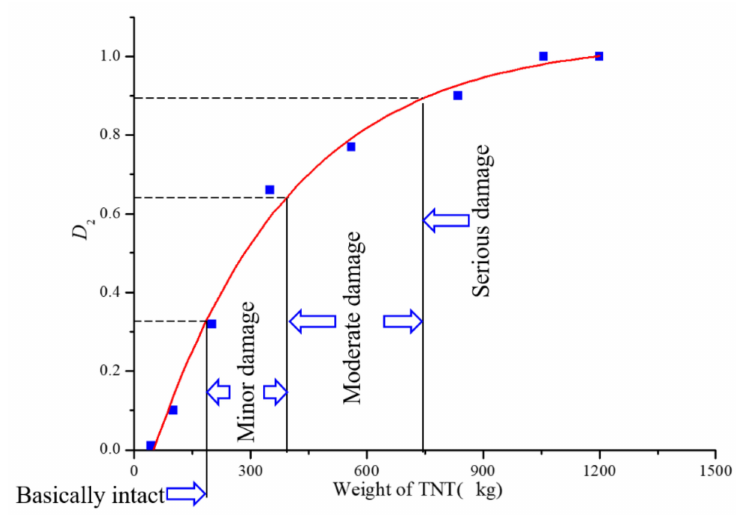
Figure 10. The degree of damage to the deep flood discharge holes for different masses of explosive. The degree of damage category can be obtained from the value of D 2 calculated by Equation (7) using the classification shown in Figure 11.